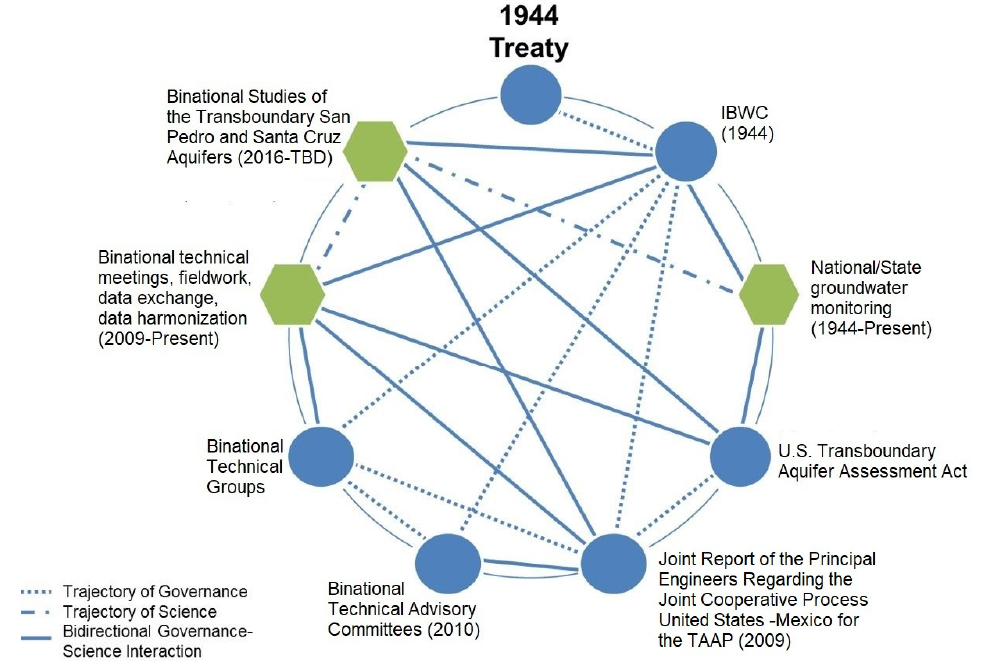
Figure 5. The path to bidirectionality/binationality in the TAAP. Governance elements are represented by blue circles; science elements are represented by green hexagons. Figure by authors.